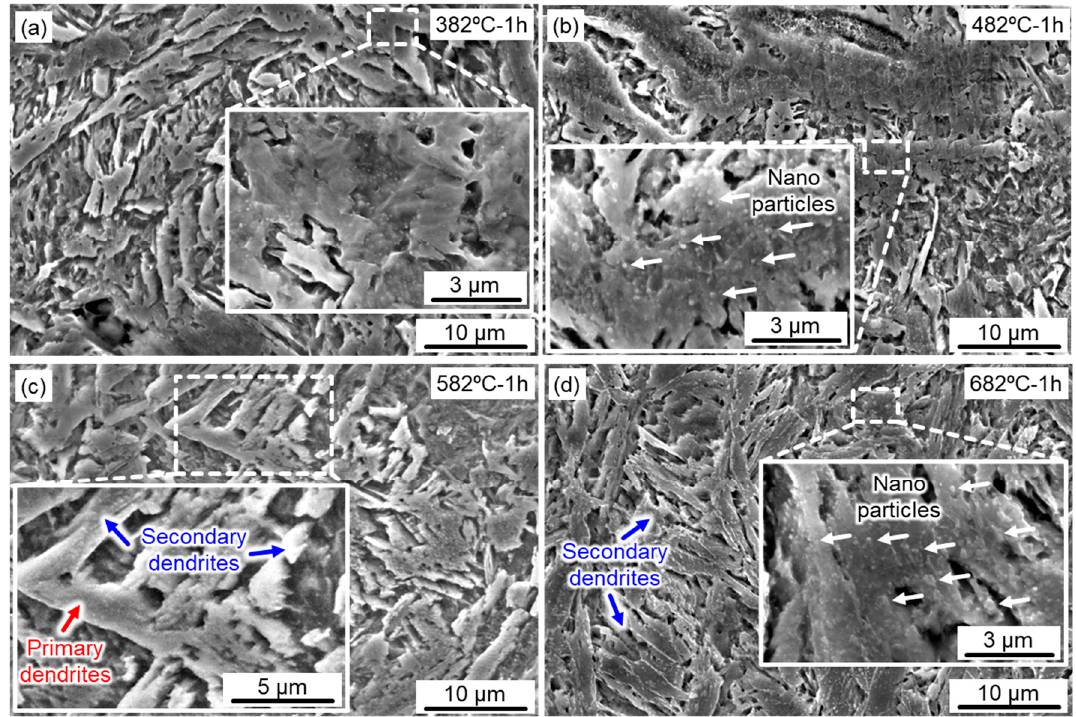
Figure 3. Microstructural evolution of the aged SLM 17-4 PH steel at various aging temperatures for 1 h: ( a ) 382 °C; ( b ) 482 °C; ( c ) 582 °C; ( d ) 682 °C.